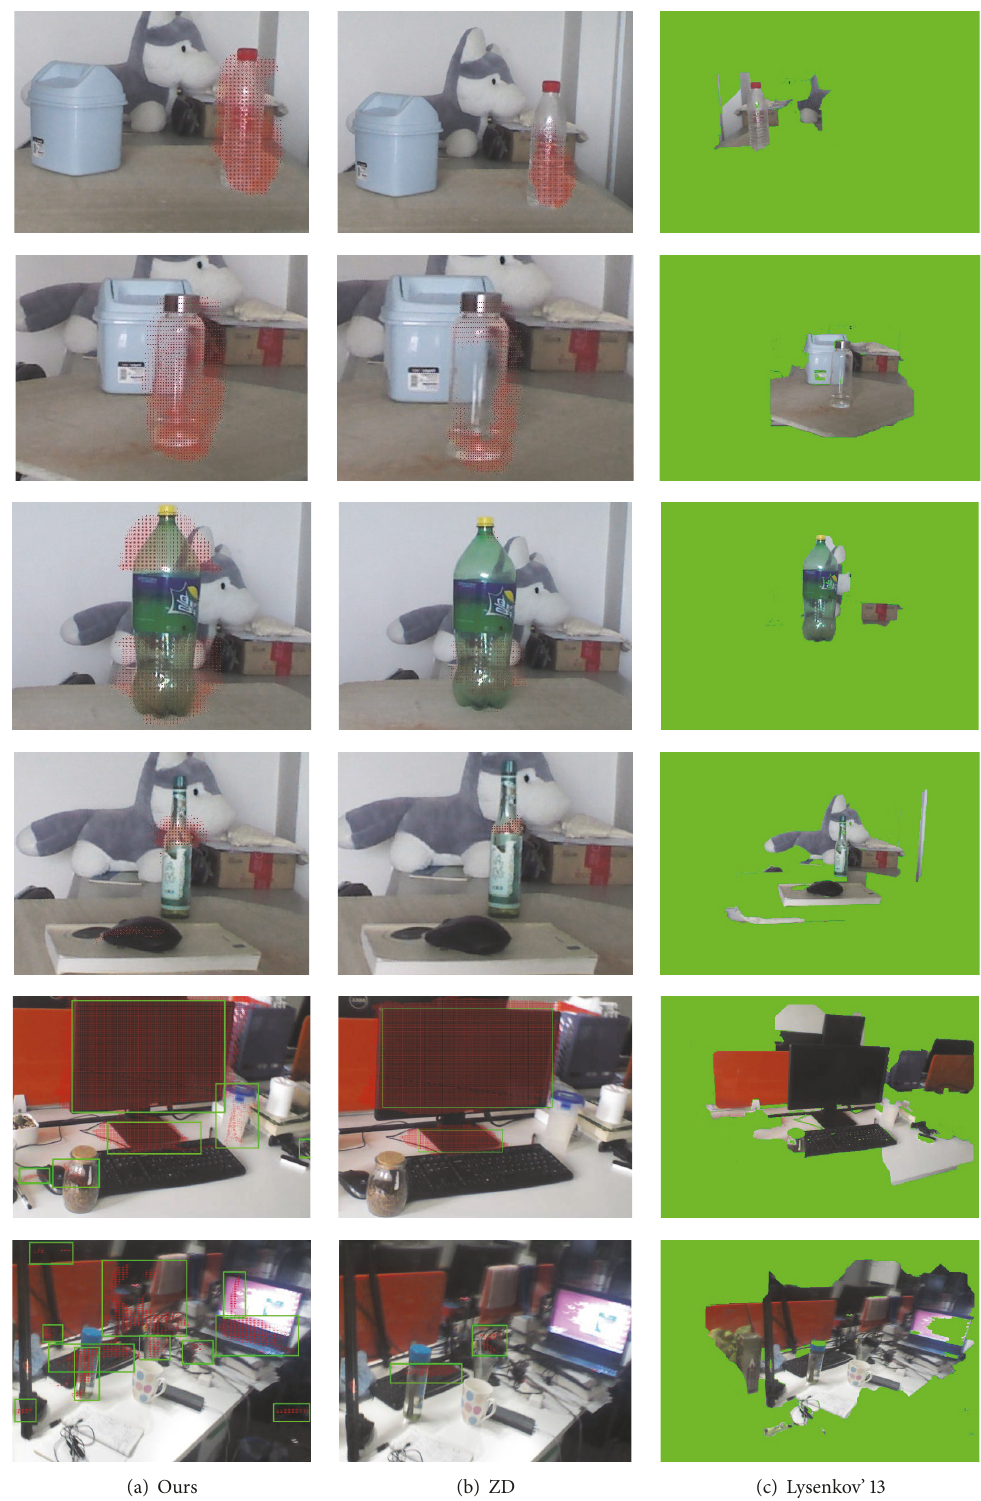
Figure 6: (a) Noisy voxels detected by our method, red points are reprojection of the voxels on a color image. (b) Reprojection of ZD region on a color image. (c) 2D noise regions detected by [6]. The sequence of examples is the same as Figure